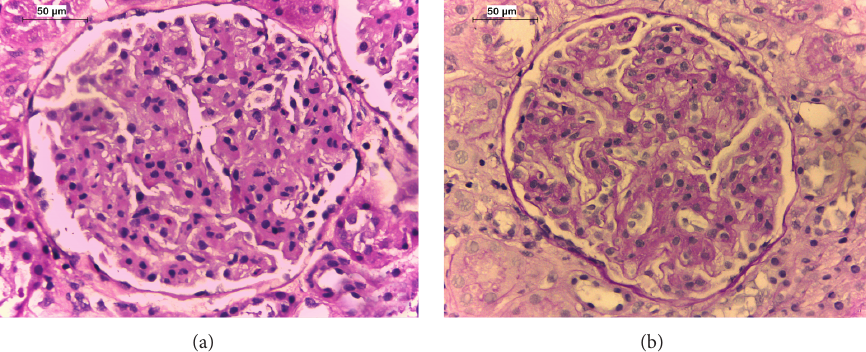
Figure 1: Histology of the patient renal biopsy. (a) Proliferation of mesangial and endothelial cells and expansion of the mesangial matrix (hematoxylin and eosin stained section; original magnification × 400); (b) global endocapillary proliferation and a double contour appearance of the glomerular basement membrane (periodic acid-Schiff stained section; original magnification ×